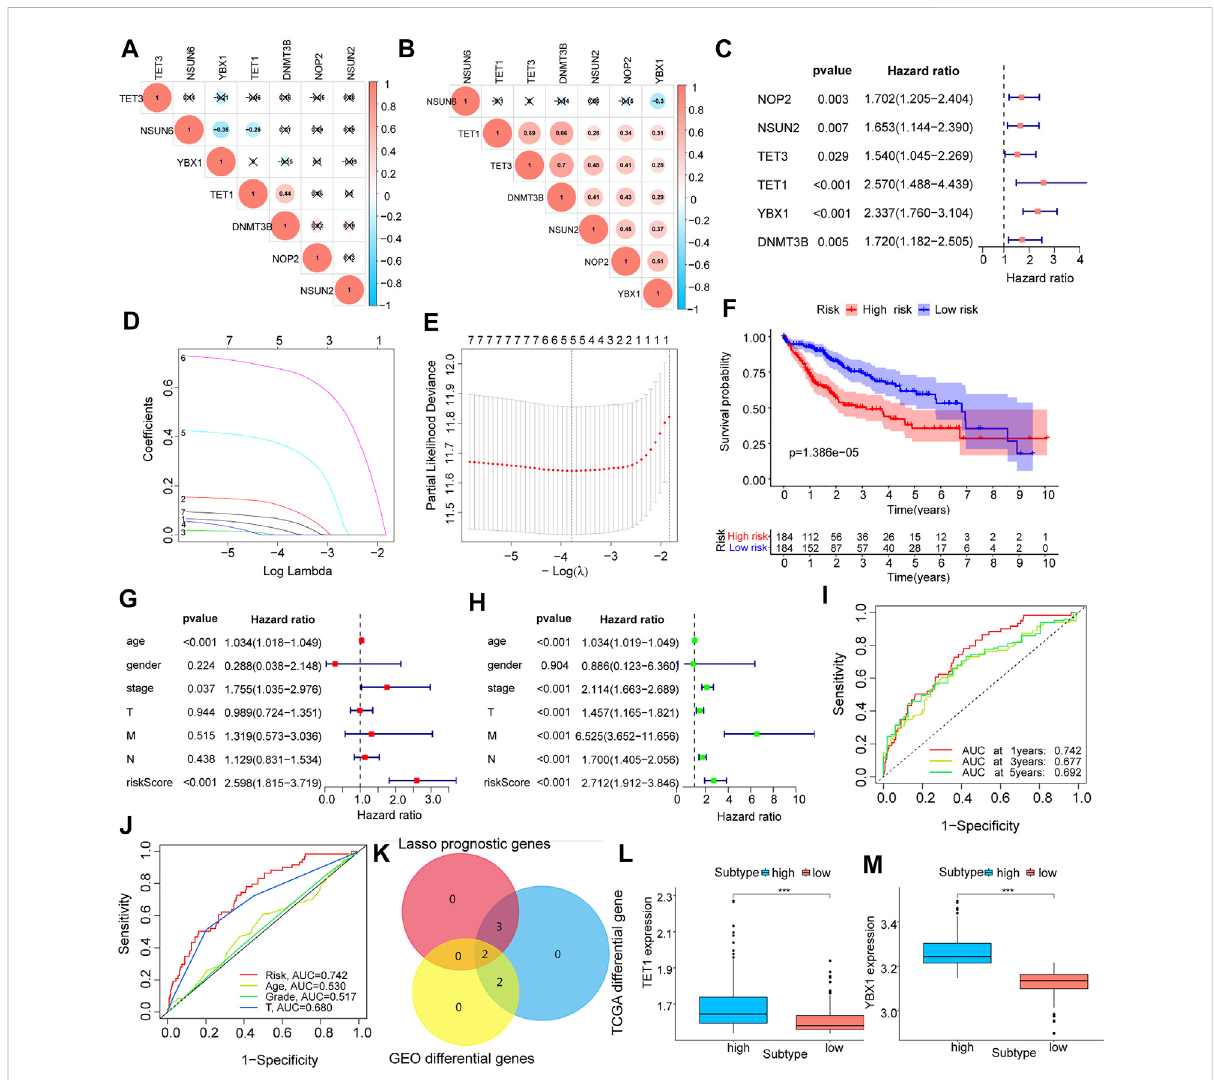
FIGURE 2 Expressioncharacteristicsandprognosticmodelconstructionofm5Cregulatorgenesinhepatocellularcarcinoma. (A,B) :m5Cregulatorgenes co-expression analysis in the corrected GEO (A) and TCGA (B) expression matrices; (C) : identify m5C regulator genes associated with prognosis by univariate COX regression analysis, forest plots show the screened genes; (D,E) : show the regression coef fi cients in the LASSO regression algorithm andthecross-validationintheproportional riskmodel toadjust theparameter, fi nalize thebest parameter( λ )toscreenthemostrelevant genes for hepatocellular carcinoma; (F) : survival analysis of different LASSO subgroups; (G,H) : multivariate and univariate analysis of risk scores combined withclinicalfactorssuchaspatientage,gender,andTNMstage; (I,J) :AUCanalysisofprognosticmodelandclinicalcharacteristics; (K) :Venndiagram mapping of differential genes in GEO and TCGA liver cancer samples and the intersection of genes screened out by LASSO; (L,M) : expression of key genes TET1 and YBX1 in each LASSO